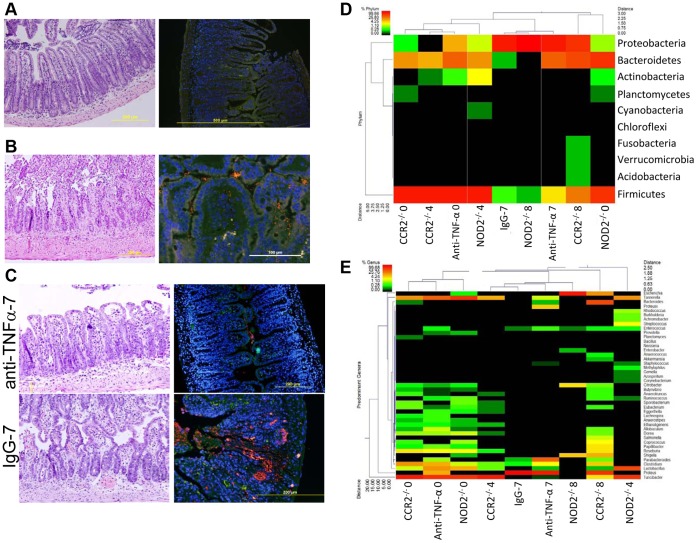
Dysbiosis and E. coli invasion are modulated by genetic susceptibility and pharmacotherapy.(a) CCR2−/−8 (n = 5) are protected from T. gondii-induced ileitis (median inflammation score 3, range 2–3) and E. coli invasion. (b) NOD2−/−8 (n = 5) develop severe ileitis (5, 5–7) and E. coli invasion. (c) anti-TNF-α mAb-7 (n = 5) reduces ileitis (4, 2–4 vs 4, 4–7) and decreases bacterial invasion relative to IgG-7 controls, n = 5). Histology, H&E 40x; FISH, CCR2−/−8 and anti-TNF-α-7 =  Cy3-EUB338/non-EUB338-6FAM; NOD2−/−8 and IgG-7 =  Cy3-E. coli/EUB338-6FAM, 40x. (d,e). Pyrosequencing reveals that T. gondii-induced dysbiosis is modulated by genetic susceptibility and pharmacotherapy. Abrogating ileitis maintains microbial diversity (CCR2−/−8), whereas enhancing ileitis decreases diversity and increases E. coli (NOD2−/−8). NOD2 deletion is associated with a baseline shift to Bacteroidetes (NOD2−/−0). Anti-TNF-α mAb temper dysbiosis (anti-TNF-α-7 versus IgG-7).